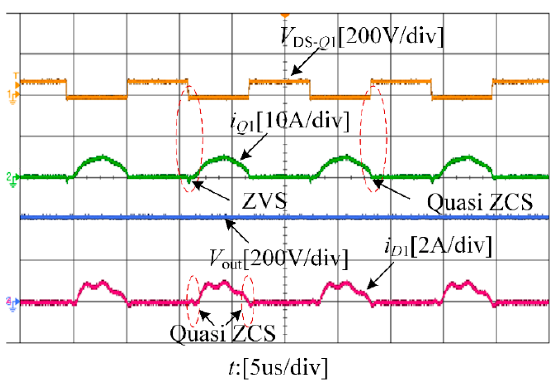
Figure 13. Experimental waveforms at the peak voltage gain point.